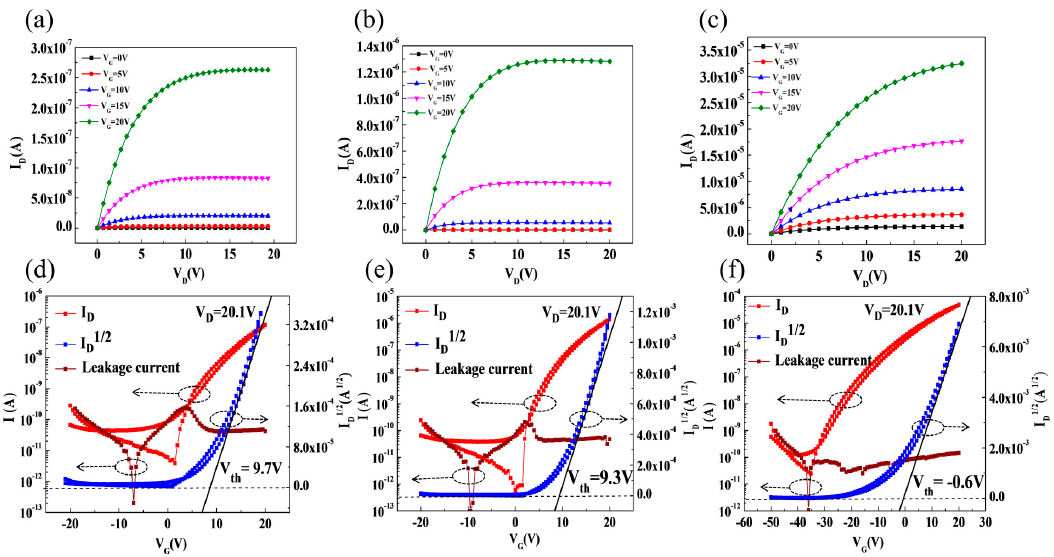
Figure 4. Output characteristics ( a – c ) and transfer characteristics ( d – f ) of devices: ( a , d ) for S1; ( b , e ) for S2 and ( c,f ) for S3. Table 1. Device parameters extracted from the transfer curves in Figure 2, including on-to-off current ratio ( I on / I off ), sub-threshold swing (SS), saturation mobility ( µ sat ), and threshold voltage ( V th ).